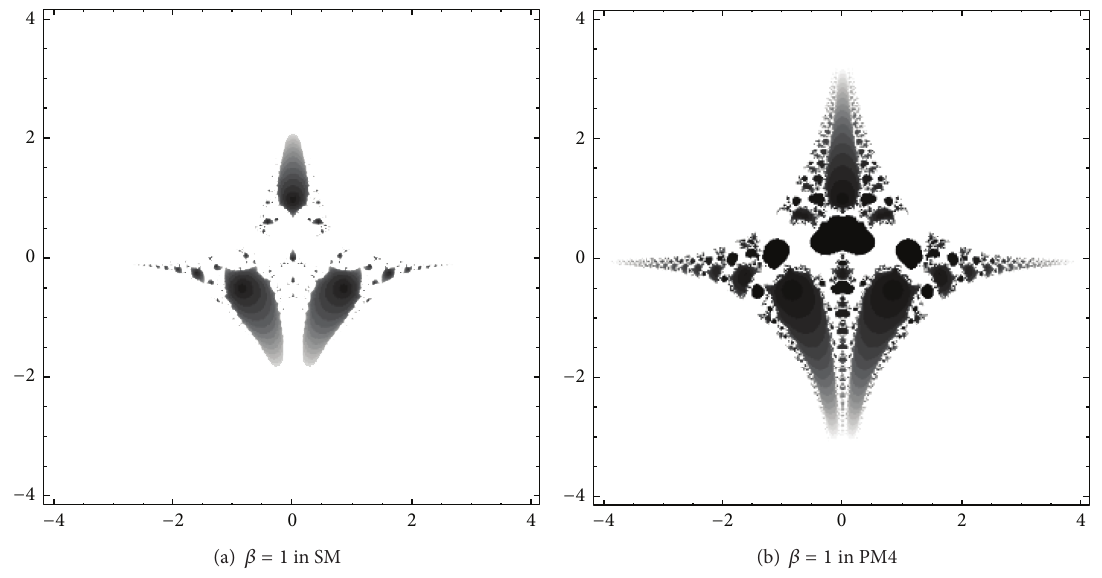
Figure 2: Attraction basins of the polynomial 𝑧 3 − 1 = 0 in the complex plane (shaded according to the number of